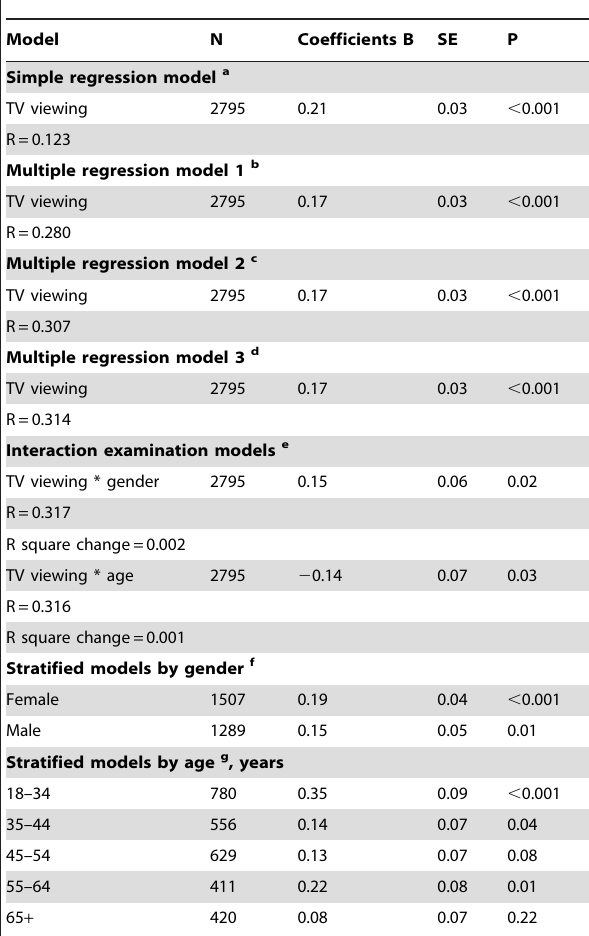
Table 2. Linear regression analyses predicting body mass index (BMI) from daily TV viewing time.